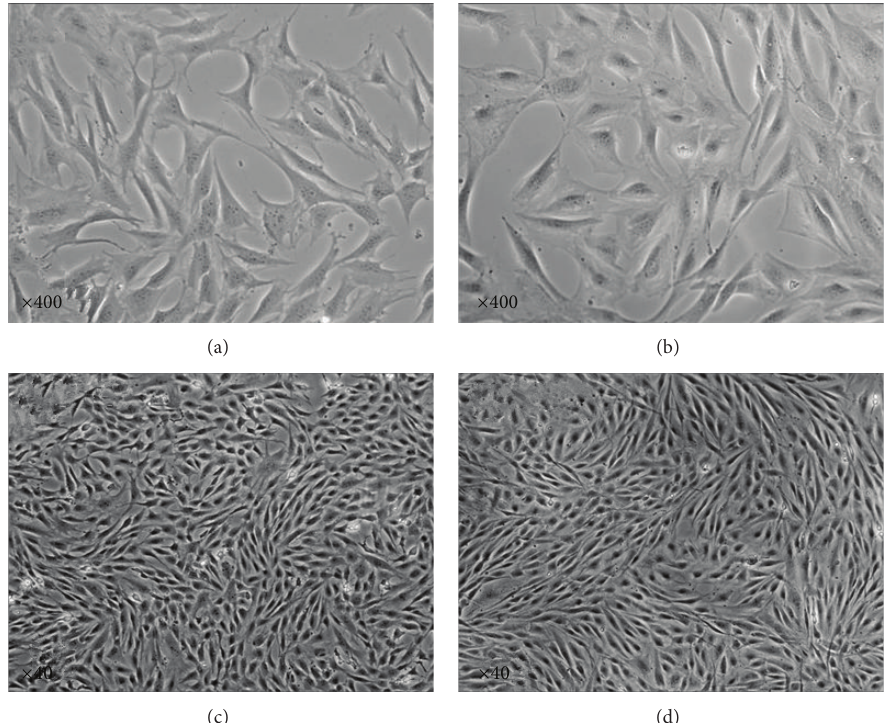
Figure 1: Morphological observation of cementoblasts and osteoblasts under